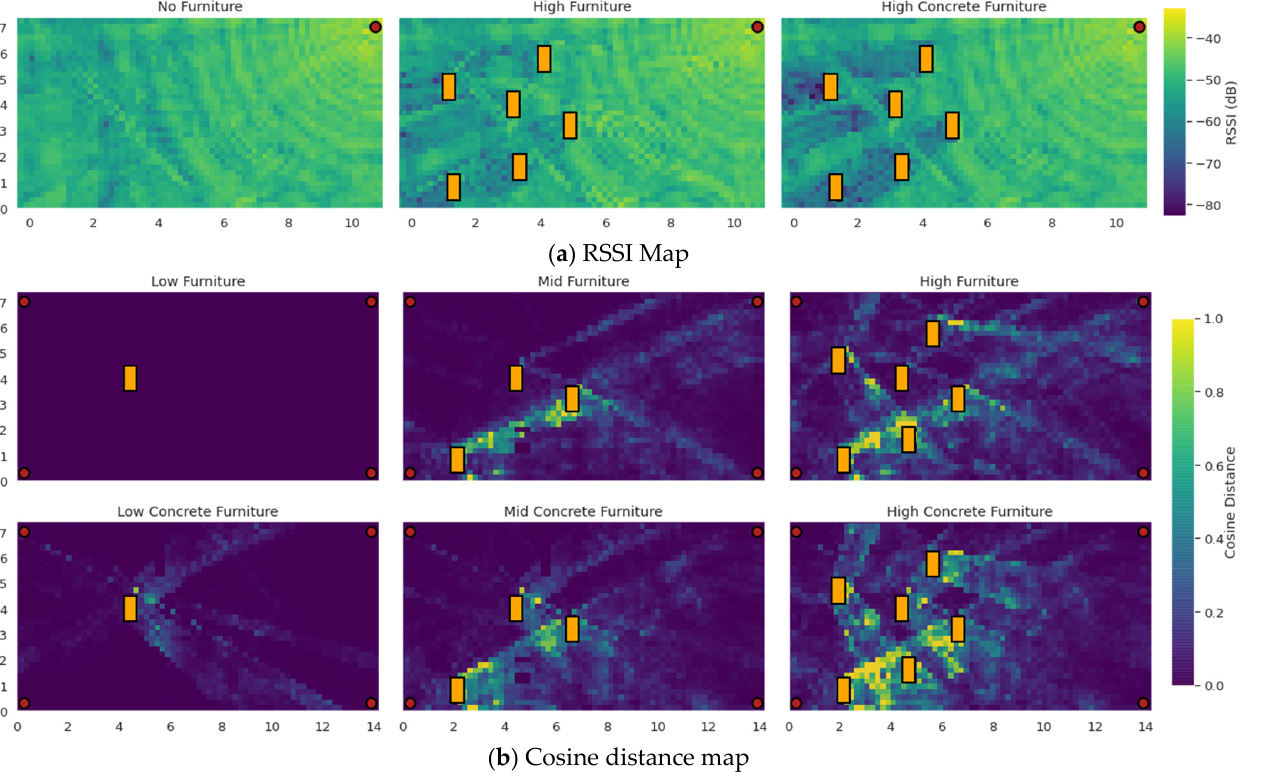
Figure 6. ( a ) Measured RSSI values by a single AP for 4 different rooms configurations and ( b ) cosine distance of IQ features between the low furniture room configuration and the rest of the furniture configurations.